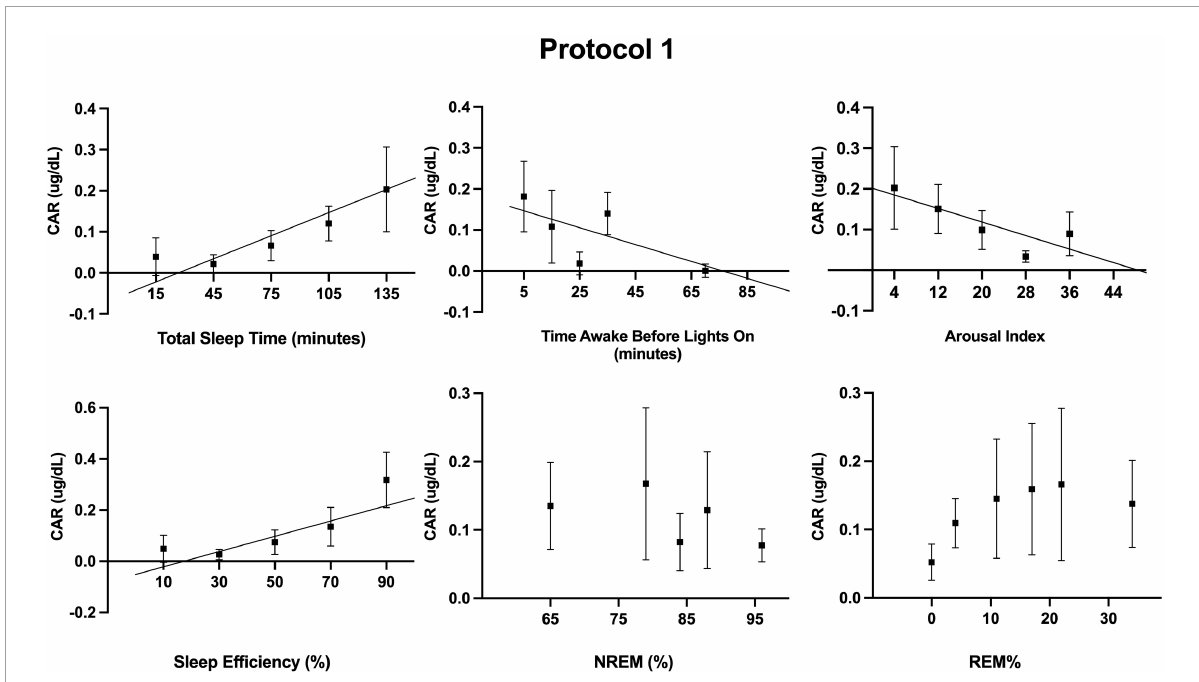
FIGURE3 Associations between measured sleep parameters during the 10 forced desynchrony sleep opportunities of protocol 1 and the cortisol awakening response (CAR). Participants’ binned data (binned into 5–6 intervals for a given sleep parameter, means ± SEM) are depicted as black squares. Binned data were averaged within an individual first, as an individual could contribute more than one point to each bin. The solid lines represent significant linear regressions as tested using mixed models (see Table 2 ). A quadratic term was also estimated but not